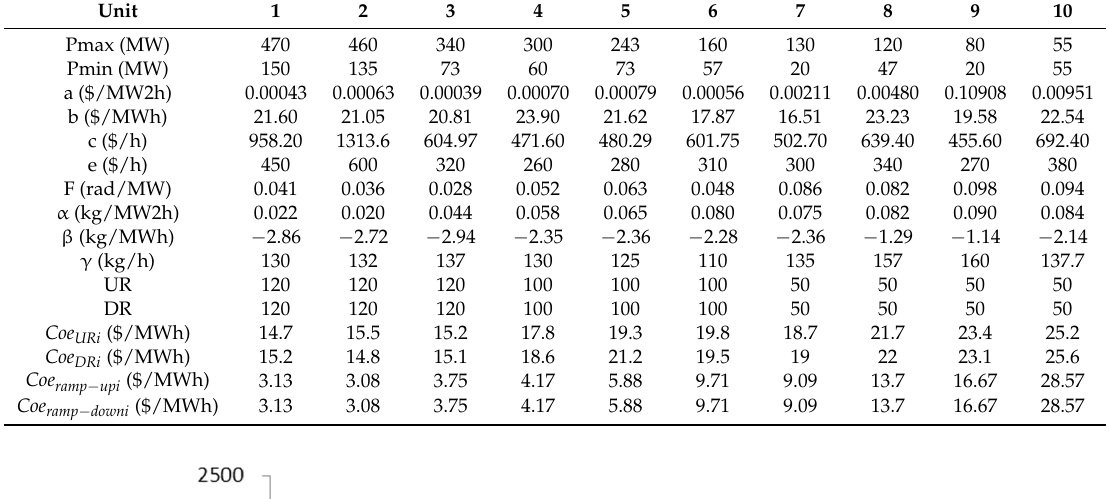
Table 2. Operating data for the Ten ‐ Unit system.